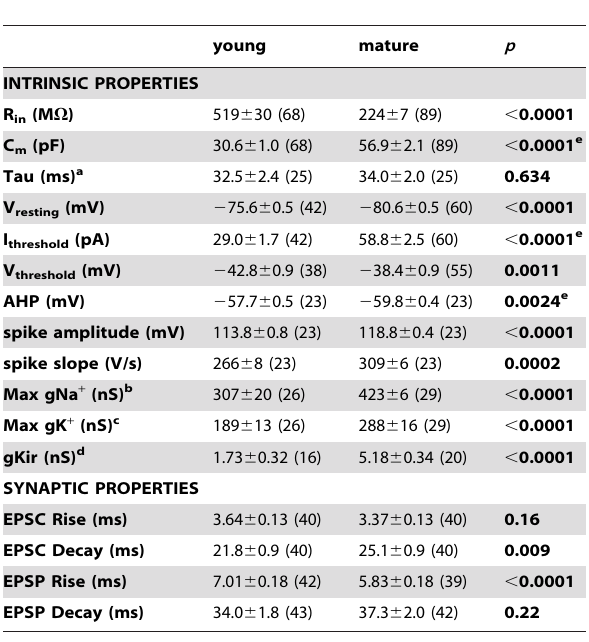
Table 1. Electrical properties of young and mature neurons